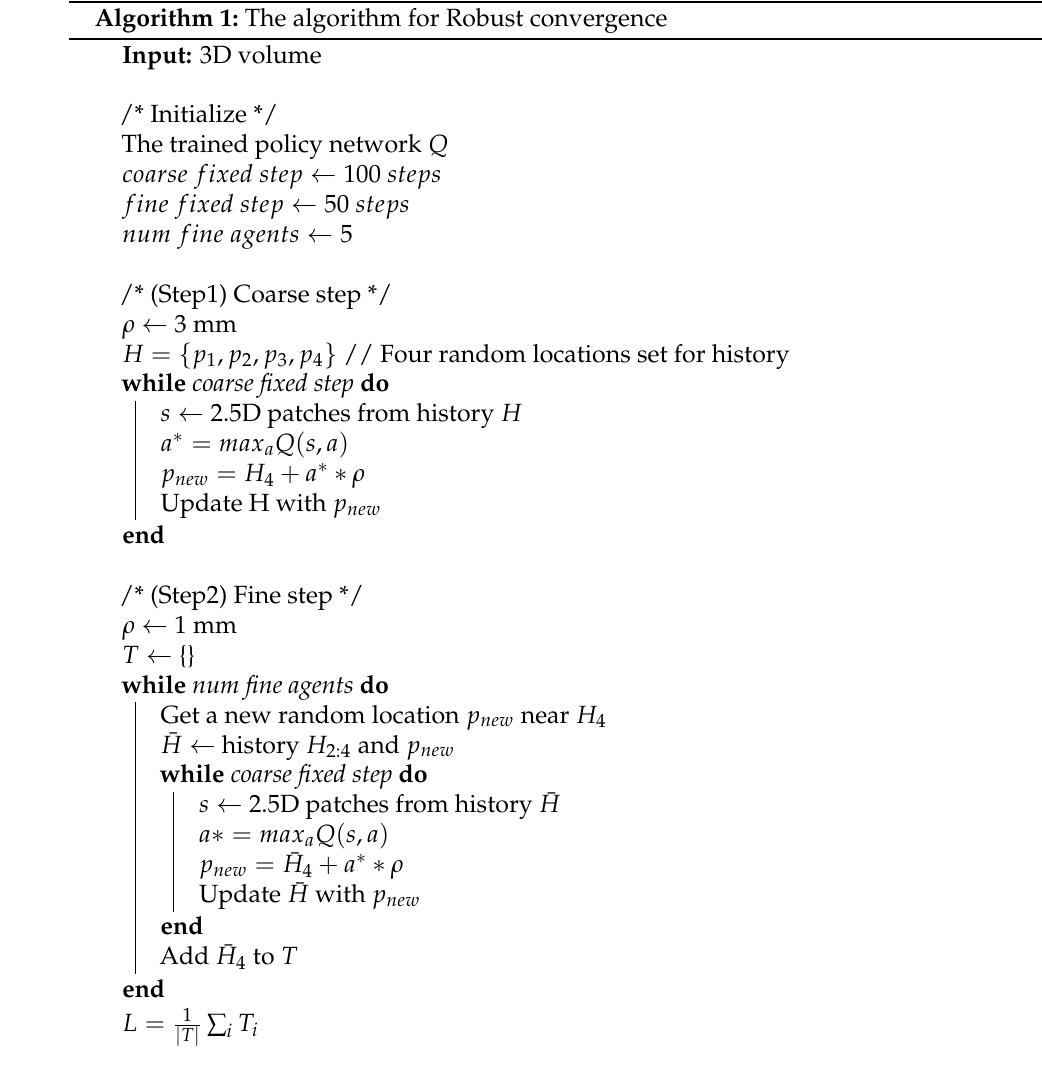
Algorithm 1: The algorithm for Robust